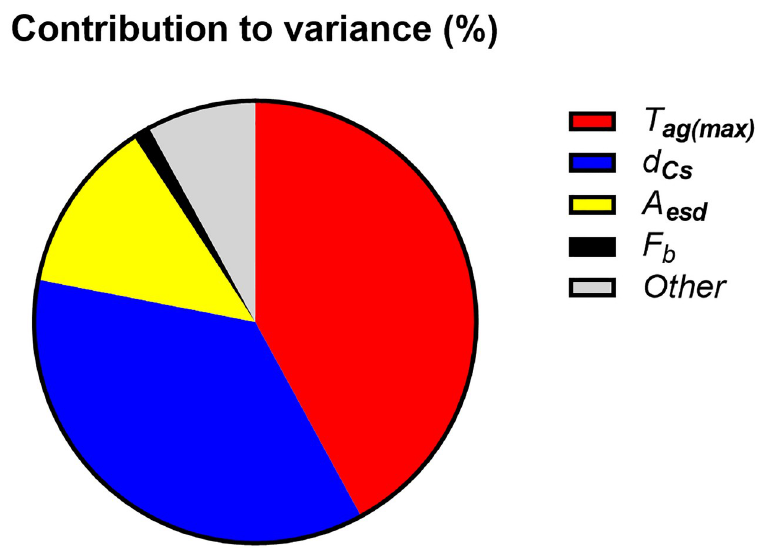
FR , h � Emax , r(t) and c 2 .